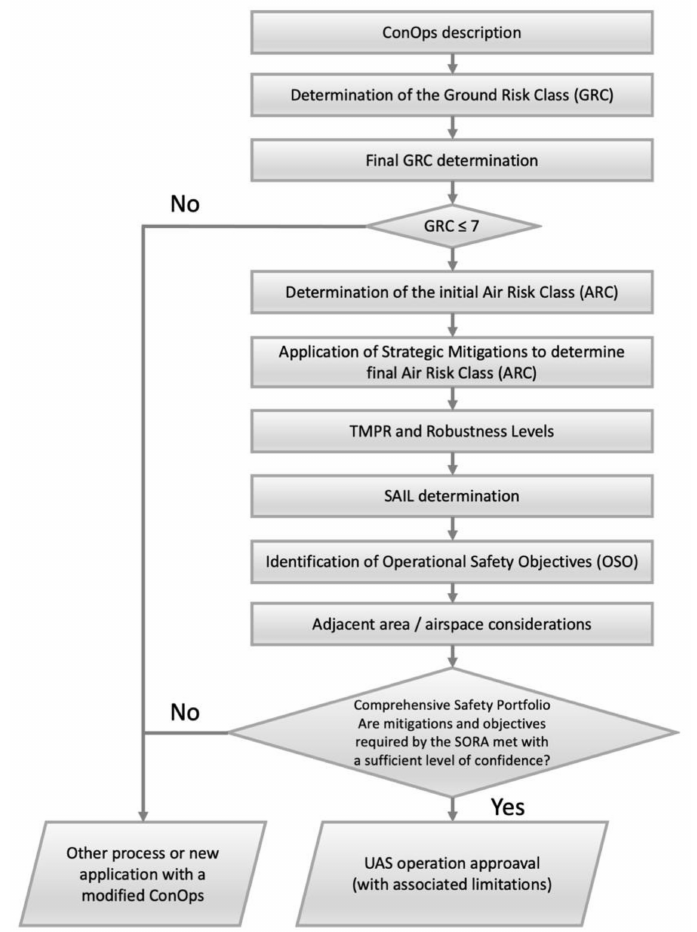
Figure 2. The SORA process adapted from [24] shows the ten steps that support the SORA